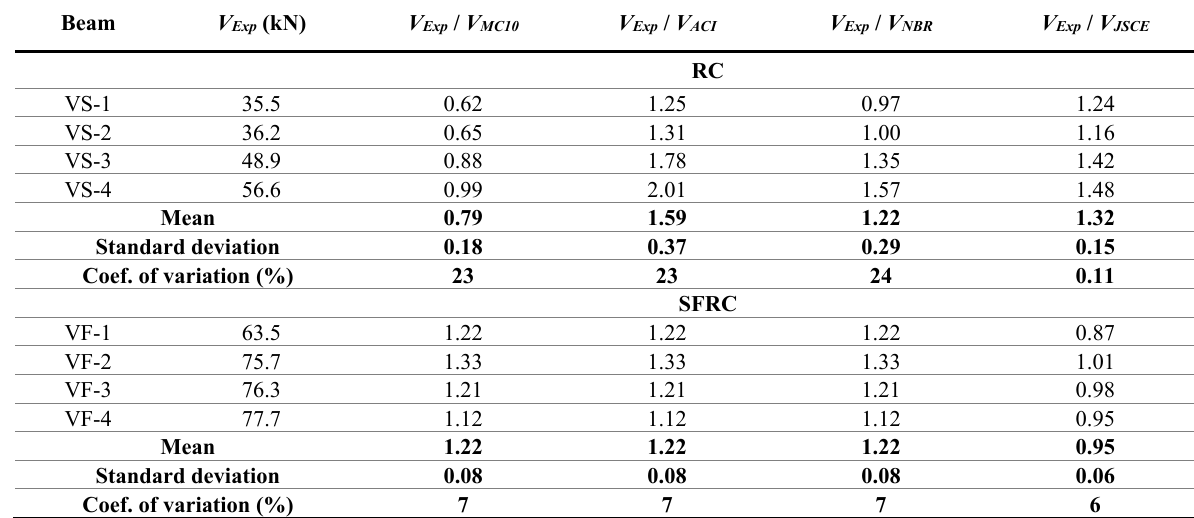
Table 6. Results estimated by the